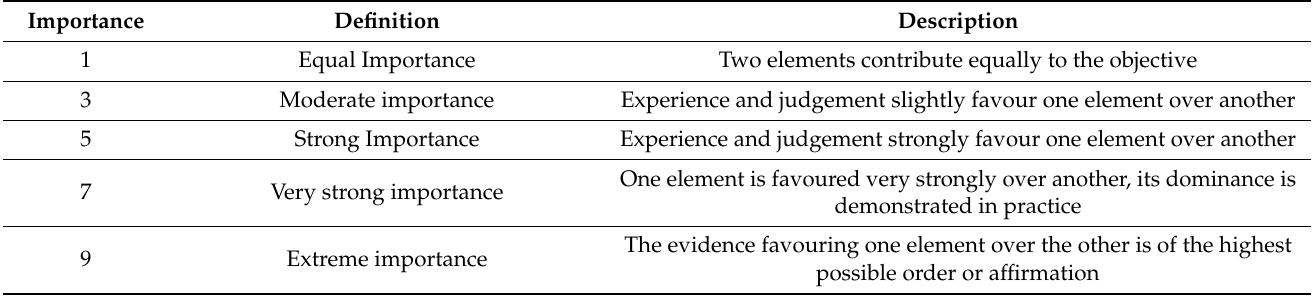
Table 1. Pair-wise comparison criteria.